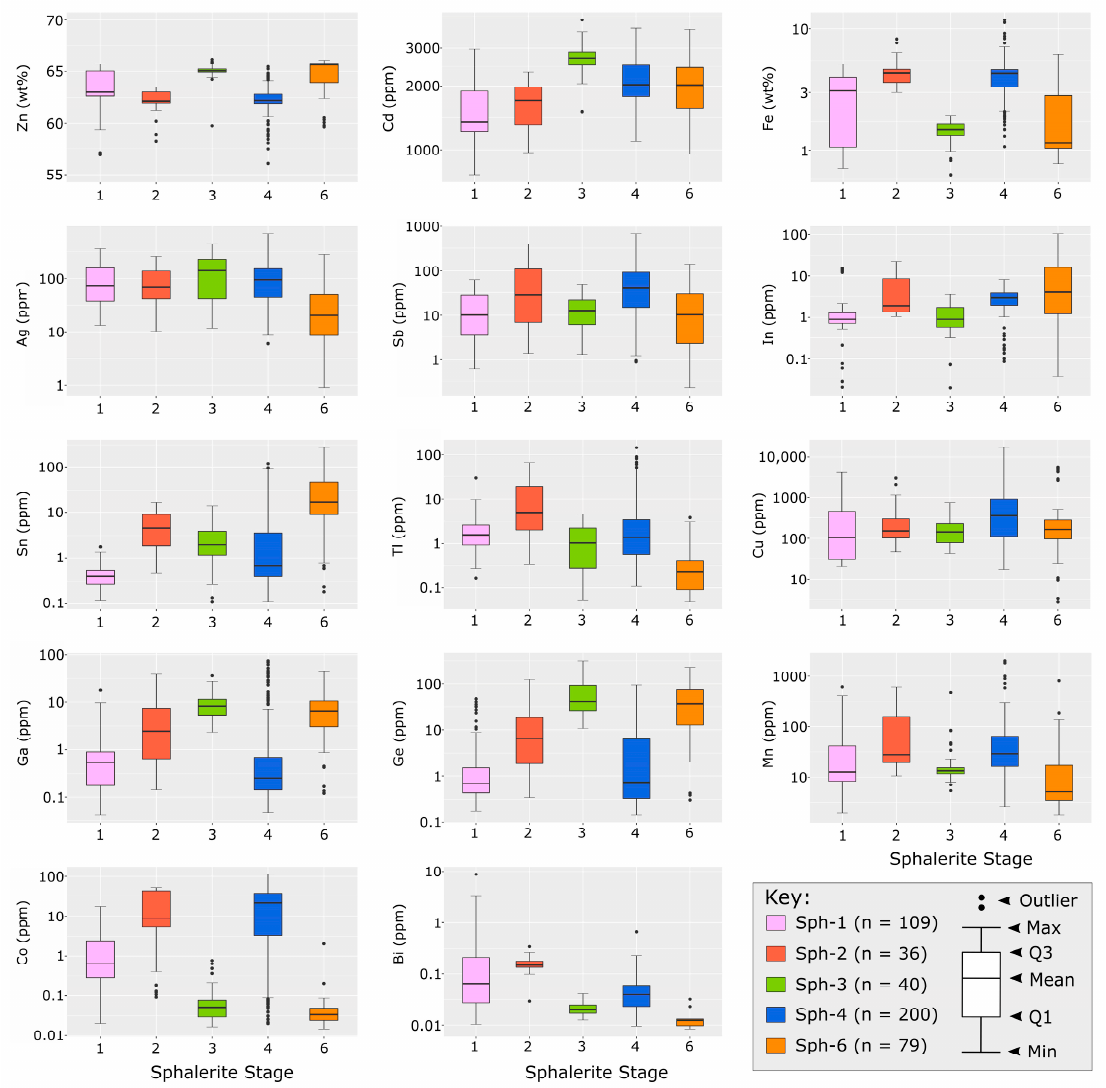
Figure 7. Box and whiskers plots of the trace elements in sphalerite analysed in this study. The box and whiskers plots are grouped into the separate sphalerite varieties.